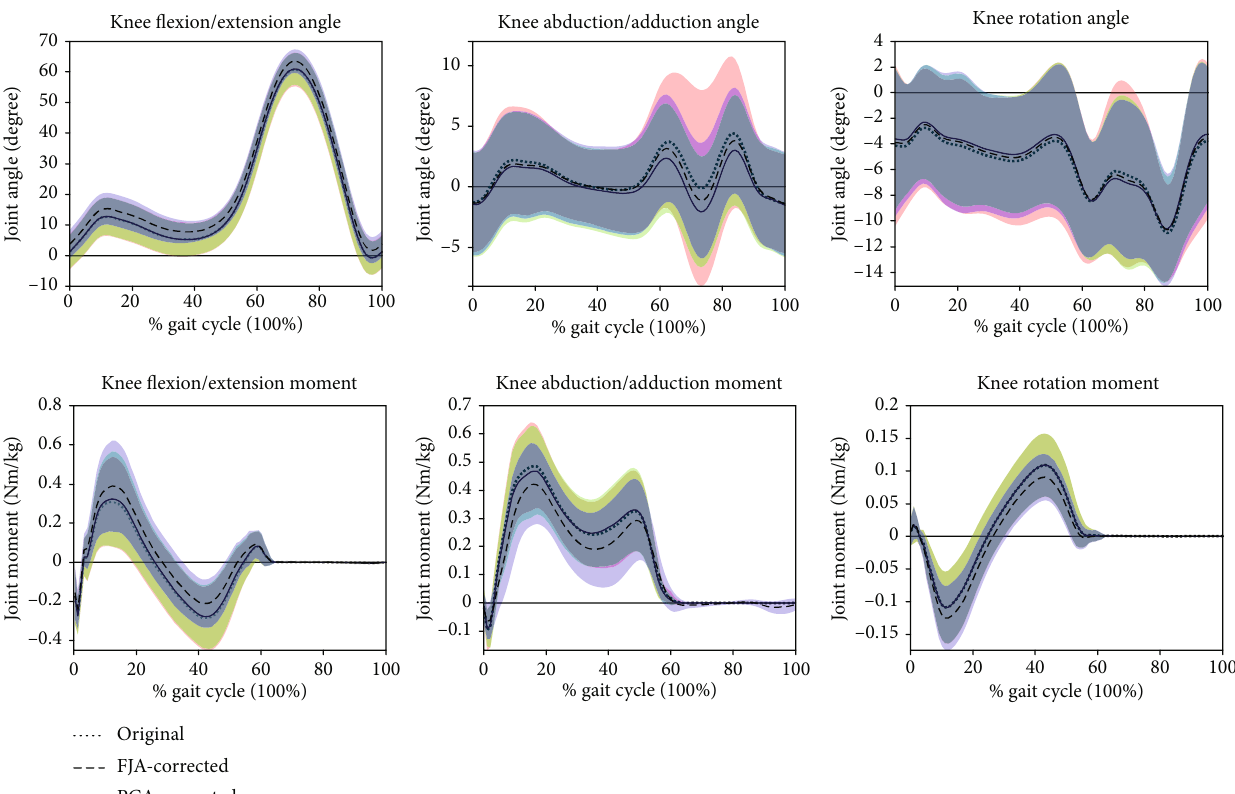
Figure 3: The knee angles and moments of patients with knee OA during a gait cycle. The shaded areas represent the standard deviation for the original